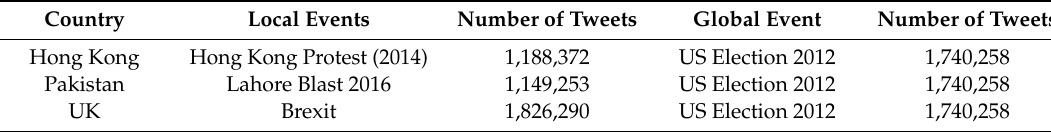
Table 2. Dataset details along with local and global events for each